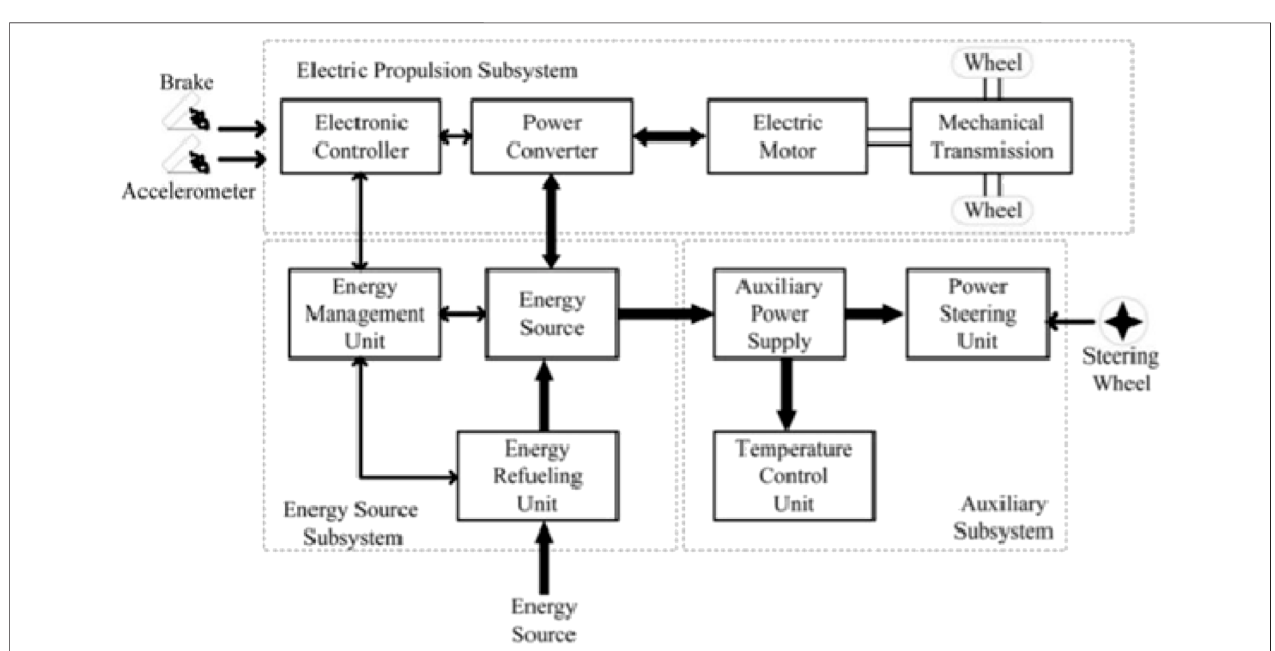
TABLE 2 | Advantages and Disadvantages of FCEV (Rose, 2015).